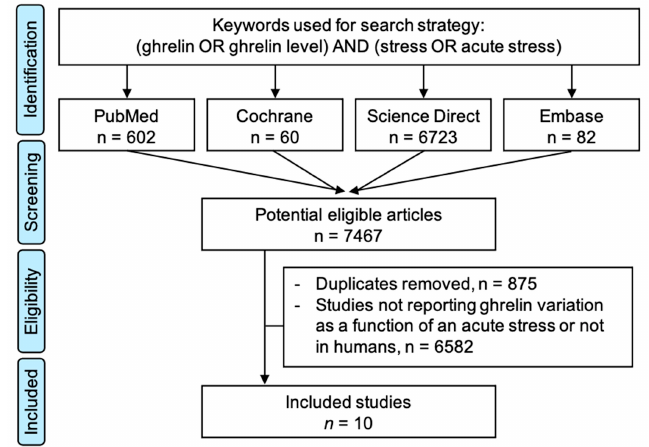
Figure 1. Search